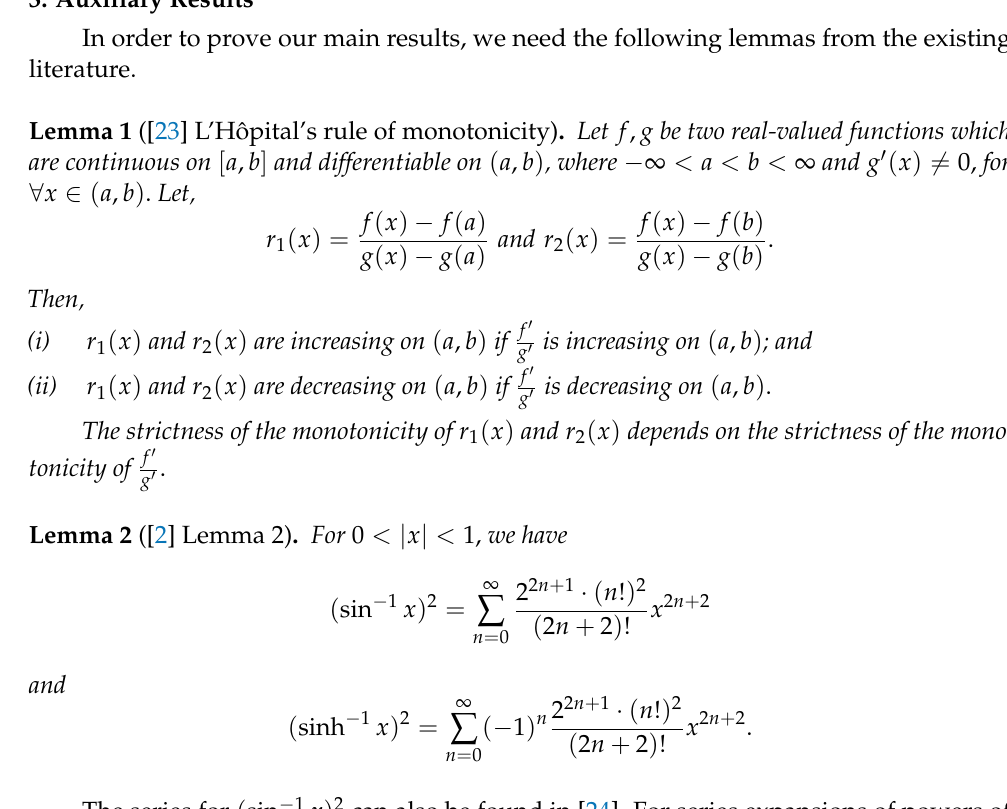
− 1 x and tanh tan − 1 x sinh − 1 x